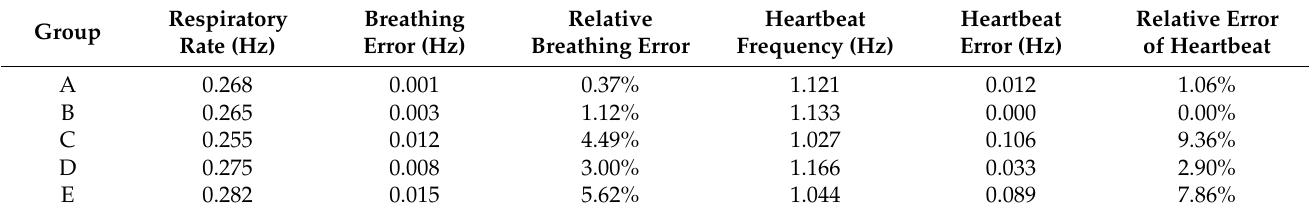
Table 5. Actual scene frequency test